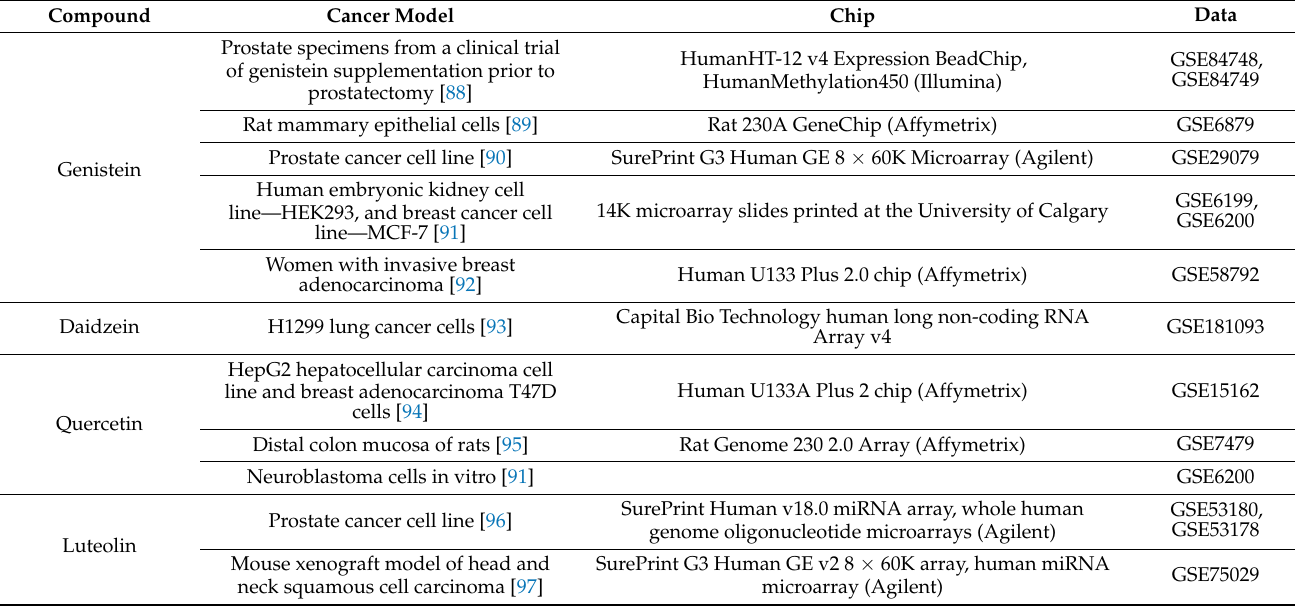
Table 6. Functional genomic studies of genistein, quercetin, and